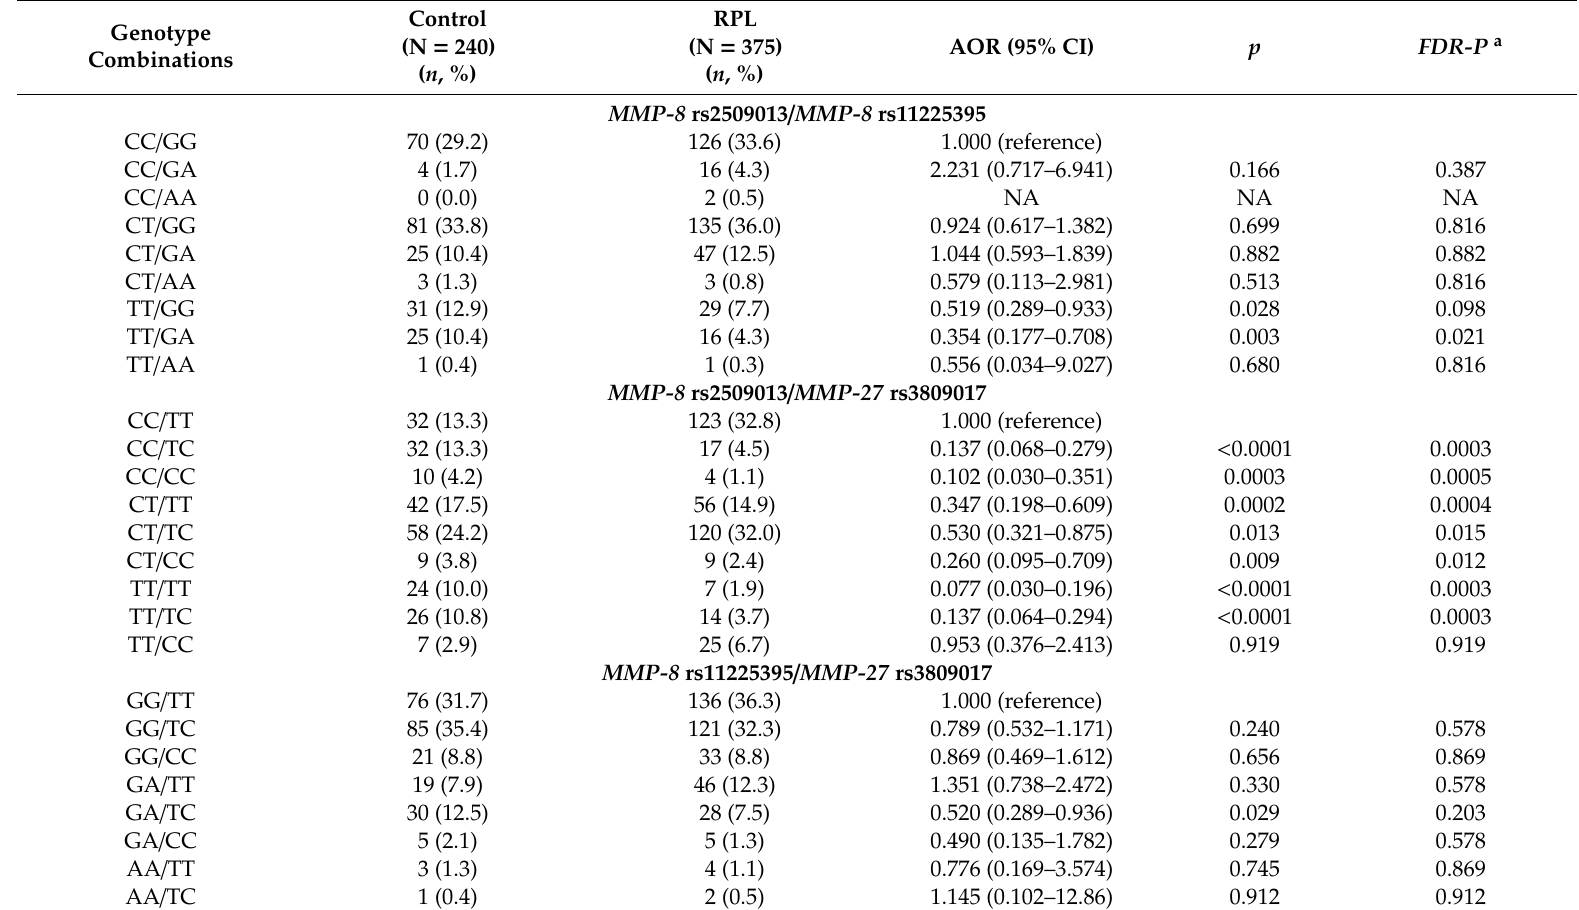
Table 4. Genotype combination analysis of MMP gene polymorphisms between the RPL patients and control